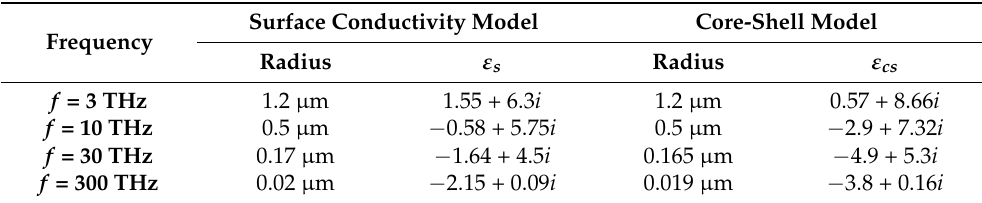
Table 1. The values of the equivalent dielectric functions, ε s and ε cs , that produce the extinction amplification resonance of charged Martian dust particles for f = 3 THz, 10 THz, 30 THz, and 300 THz. Surface Conductivity Model Core-Shell Frequency